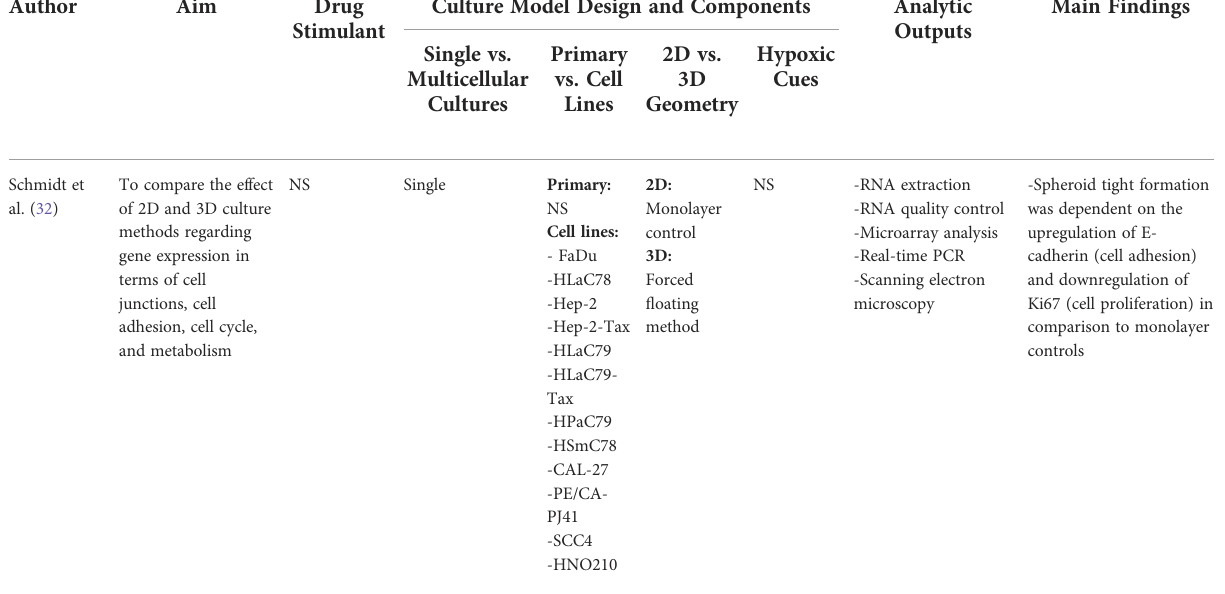
TABLE 1 Spheroid models in head and neck (H&N) cancer